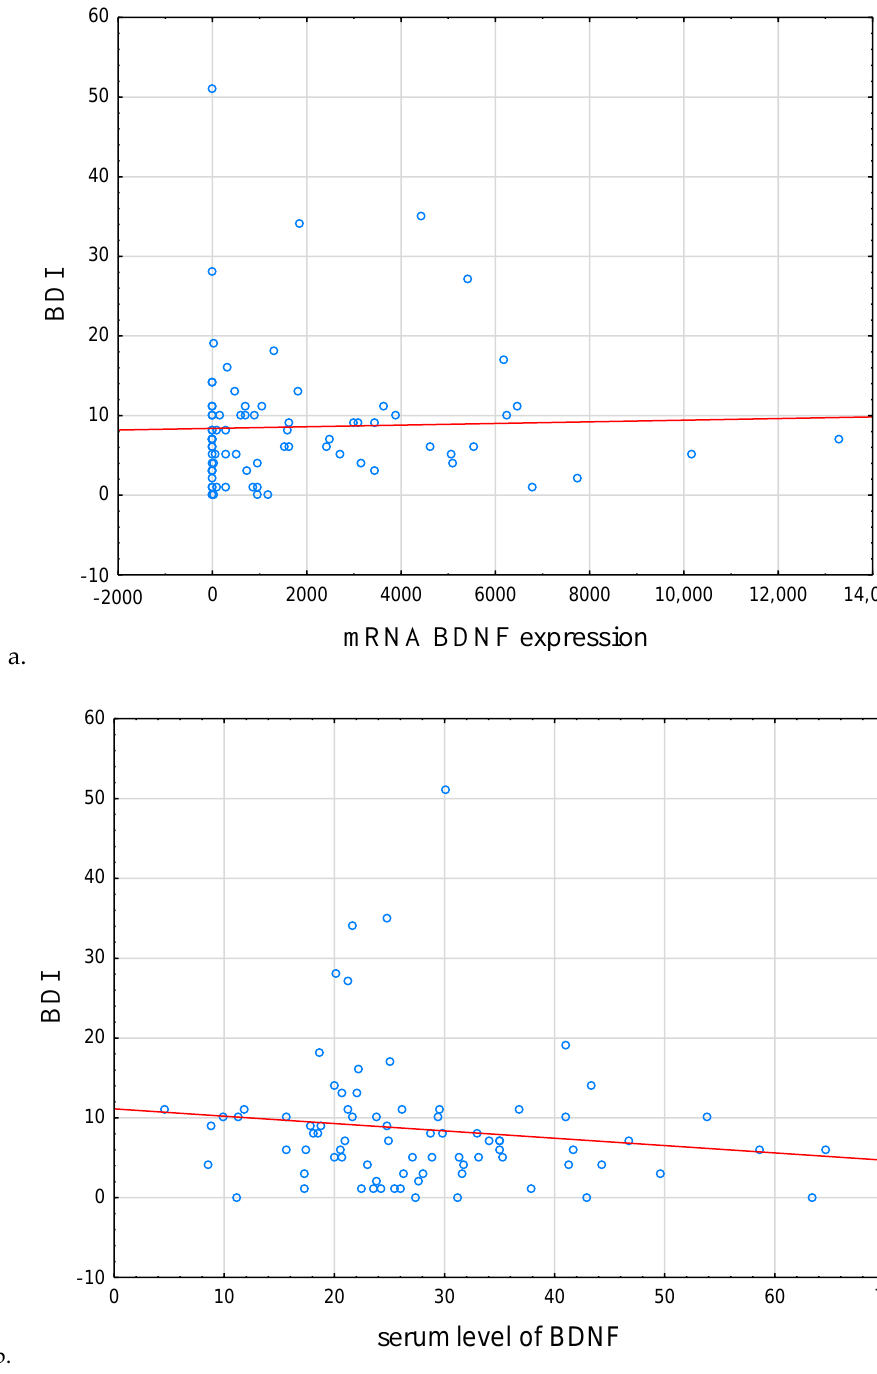
Figure 3. Correlation between BDNF mRNA expression, serum level of BDNF, and severity of depression symptoms. ( a ) Correlation between mRNA BDNF expression and BDI, ( b ) correlation serum level of BDNF and BDI. In IBD subjects in remission, the severity of depression symptoms was correlated positively with BDNF mRNA expression and negatively with BDNF protein concentration (r = 0.363, p = 0.038; r = − 0.349, p = 0.046, respectively). Abbreviations: BDI—Beck’s Depression Inventory, BDNF—Brain-Derived Neurotrophic